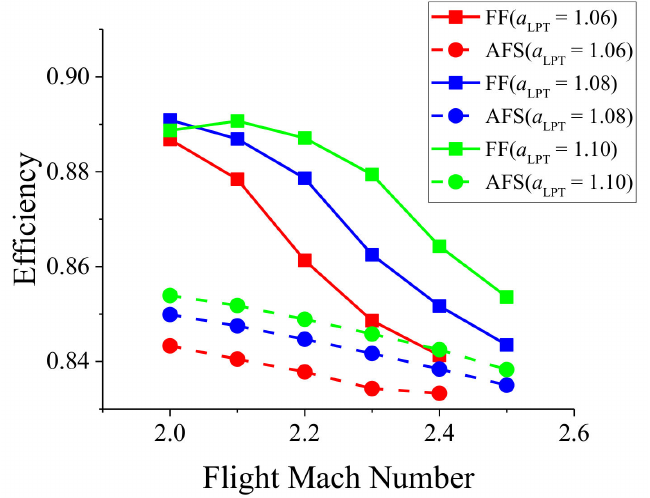
Figure 43. The Variations of Efficiencies of Front Fan and AFS at the conditions of Different Throat Area Coefficients of Low-Pressure Turbine Inlet Guide Vane ( α LPT